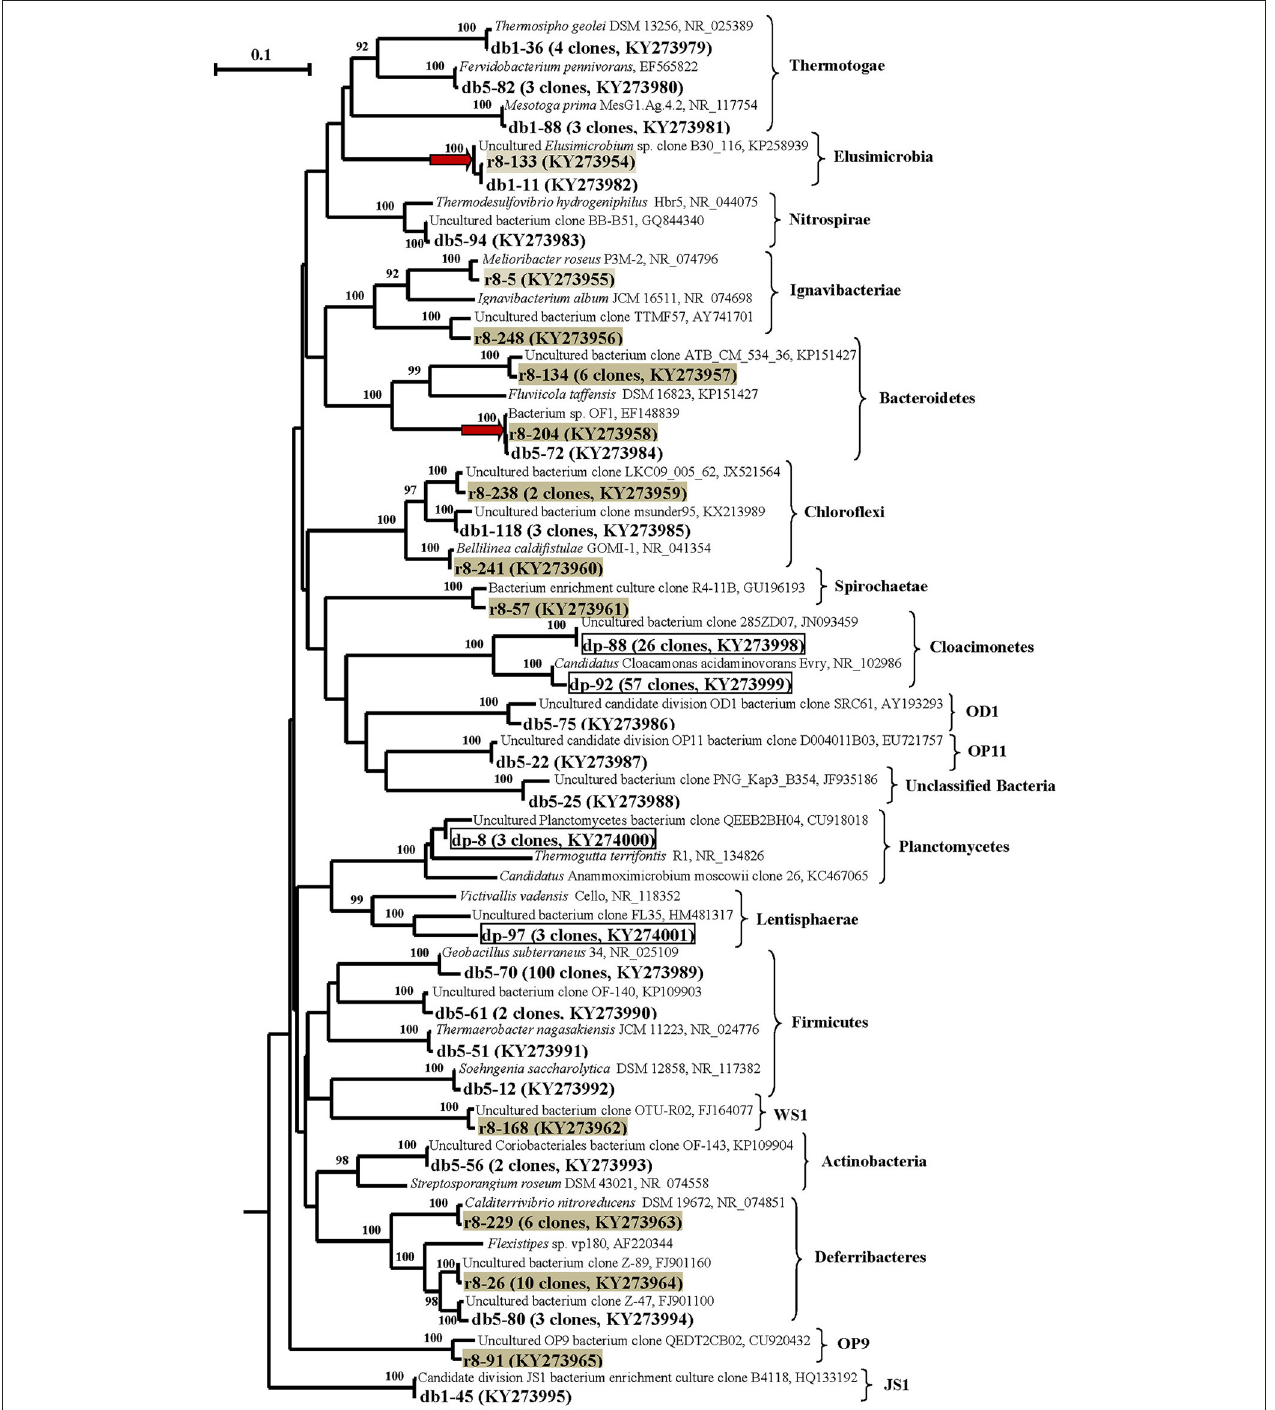
FIGURE 3 | Phylogenetic neighbor-joining tree constructed on the basis of analysis of the 16S rRNA gene and cDNA of 16S rRNA sequences of Bacteria (excluding Proteobacteria ) revealed in the DNA- and RNA-derived clone libraries of formation water from near-bottom zone of injection well 1098-8 m 3 sampled in December 2006 from the Kongdian bed. Designation: DB means DNA-based library, Bacteria clones (153 clones), DP—DNA-based library of Bacteria clones obtained with primers specific for Planctomycetes (89 clones) (marked by frame), RB—RNA-based library of Bacteria cDNA of 16S rRNA sequences (151 clones) (marked by gray filling). The clusters common for DB and RB-libraries are marked by red arrow. Scale bars show 10 (0.1) nucleotide substitution per 100 nucleotide base pairs. The numerals at the branching points show the significance of the branching order as determined by bootstrap analysis of 100 alternative trees (only bootstrap values above 85% were considered